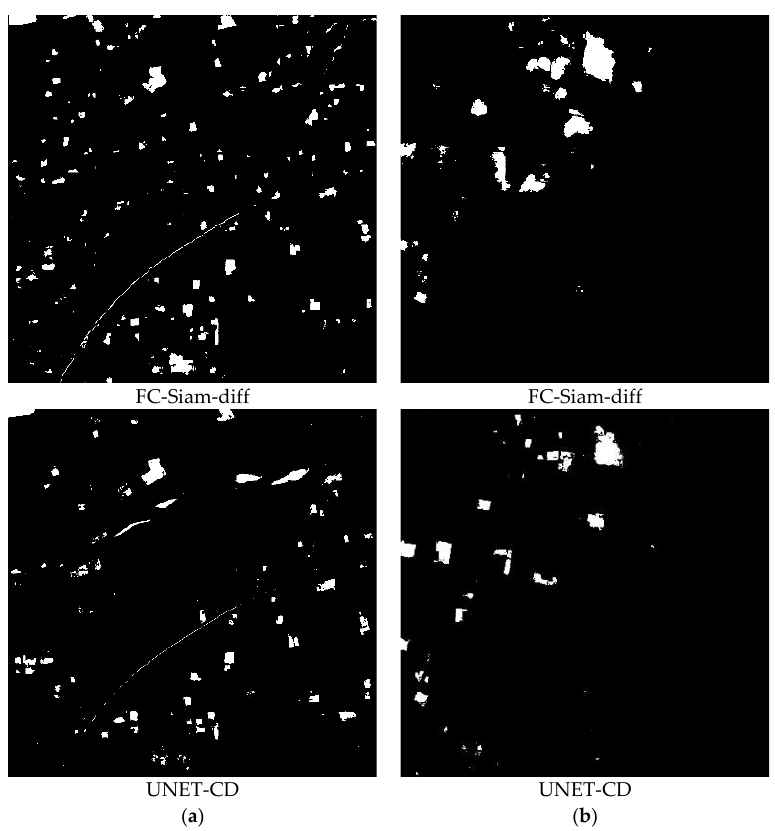
Figure 12. Change detection results: ( a ) detection results of image block 12 and ( b ) detection results of image block 15.